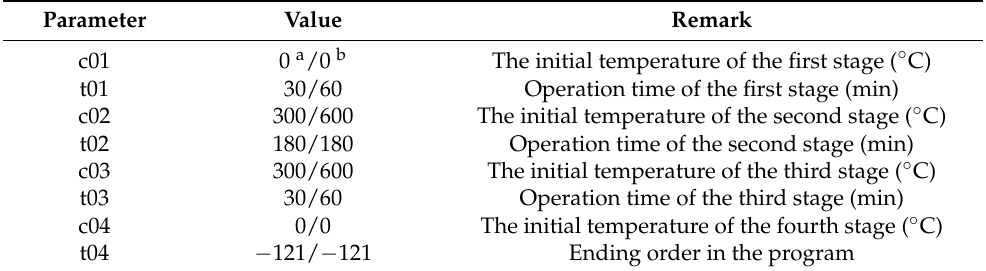
Table 1. Temporal setting of pyrolysis process in the thermal decomposition furnace.